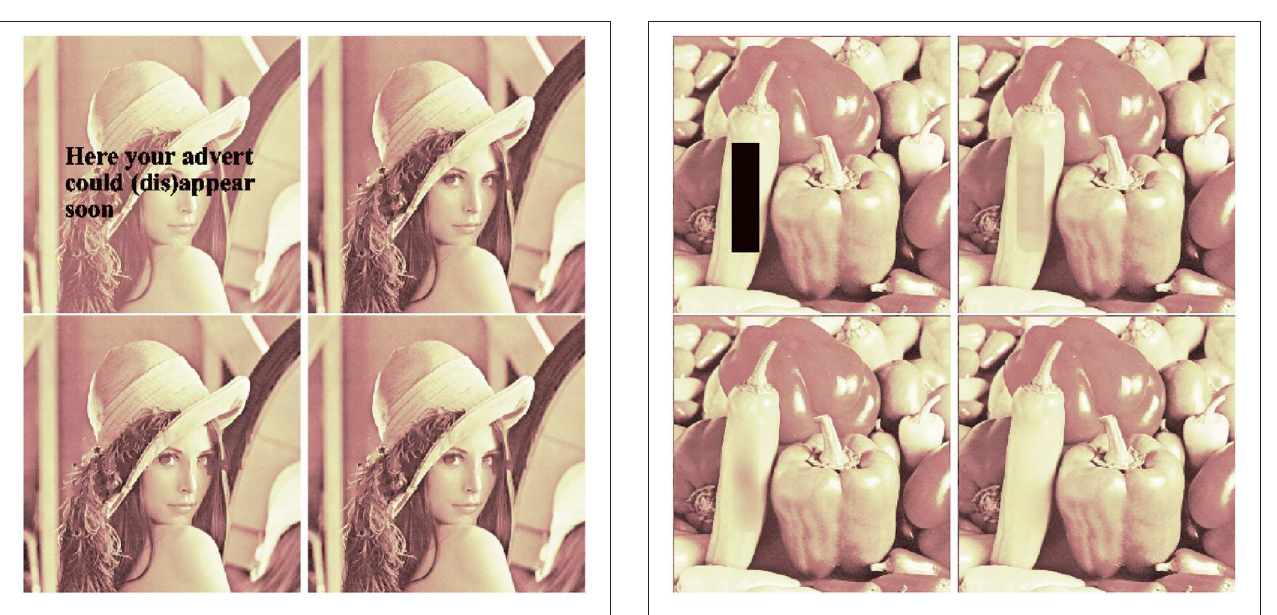
FIGURE 9 | Removing text from Lena: text image (top, left), TV inpainting (top, right), and spline inpainting using order 2 and 4 (bottom).